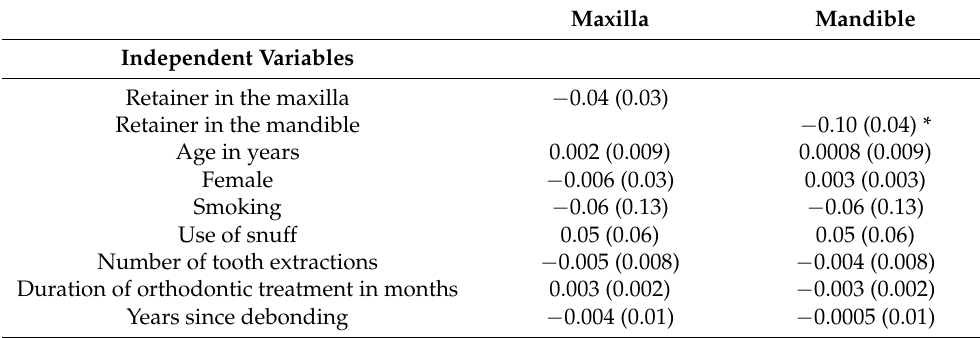
Table 9. Predictors of patient-reported orthodontic treatment satisfaction.